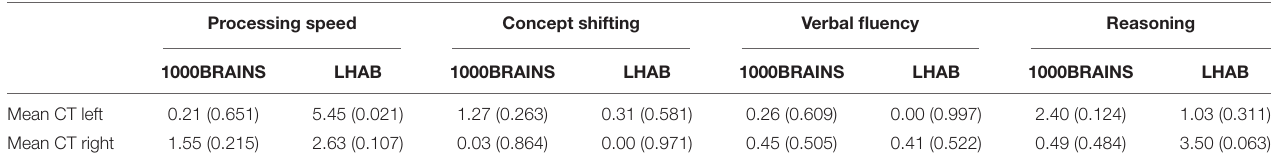
TABLE 5 | F and p -values derived from general linear models assessing the relation between annual percentage changes in cortical thickness with annual percentage changes in cognitive performance, calculated separately for the two samples, corrected for age, sex, education, and data quality (Euler number). Processing speed Concept